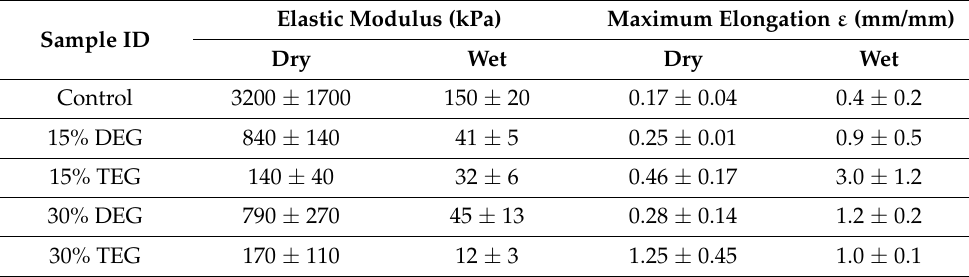
Table 2. Tensile properties of shape memory polymer foams in dry and wet conditions. n = 3, mean ± standard deviation displayed.